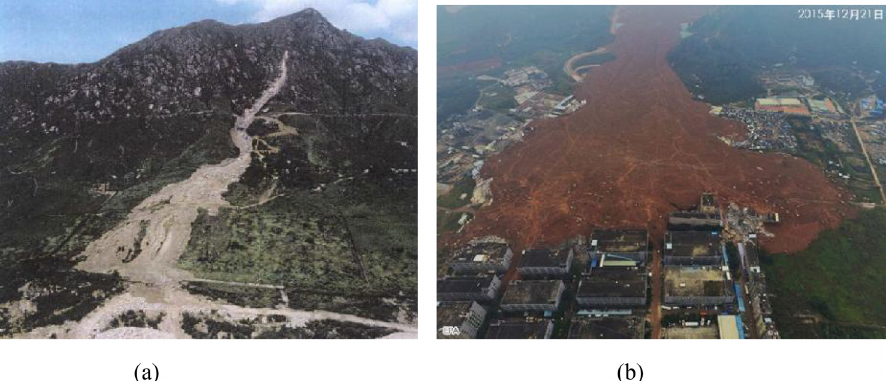
Figure 1. Representative debris flow in Hong Kong and Shenzhen, China (a) Tsing Shan debris flow in 1990 (King, 2013); (b) debris flow in Shenzhen 2015.